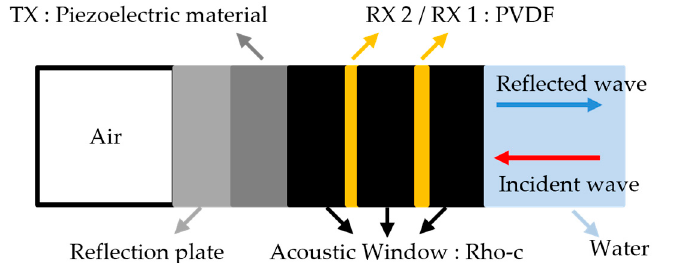
Figure 1. Schematic of smart skin.